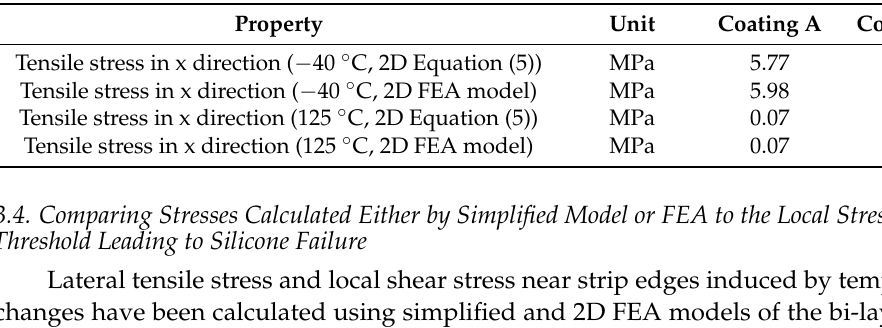
Figure 12. FEA modeling of conformal coating A stress distribution at −40 °C; x, y units are in mm. Table 3. Conformal coating tensile lateral stress calculation.